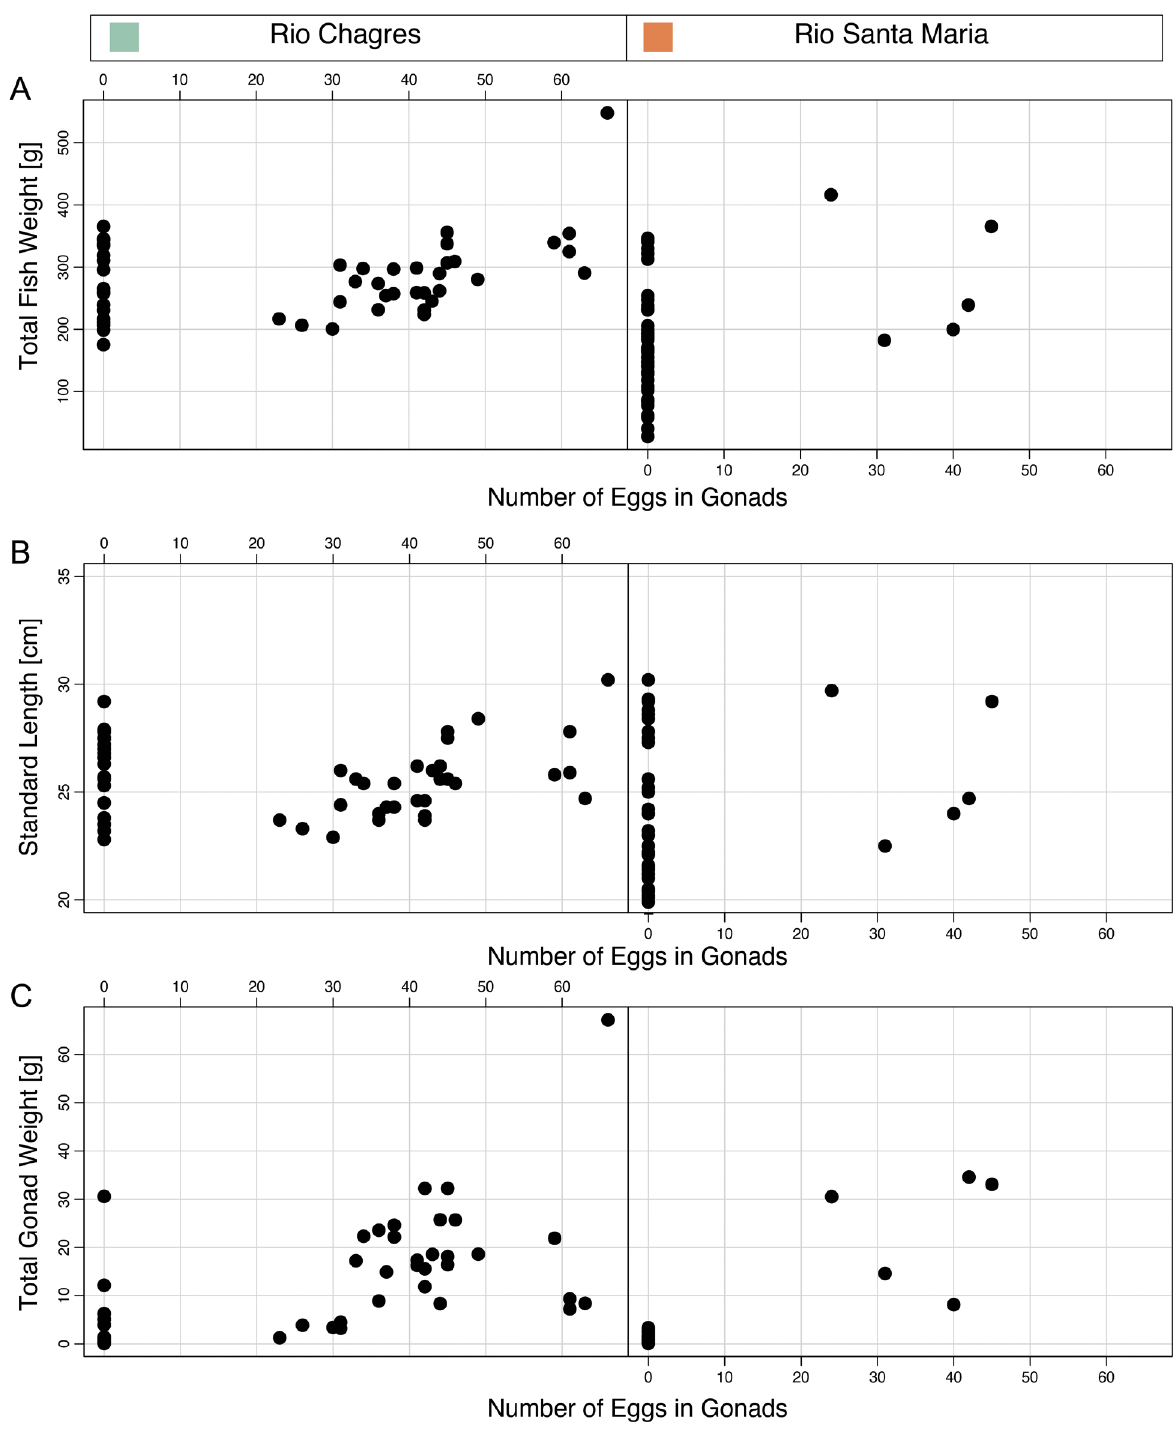
FIGURE 6 | Number of eggs of freshwater and brackish Cathorops tuyra females from Rio Chagres and Rio Santa Maria, Panama, respectively, plotted against total weight ( A ), standard length ( B ), and gonad weight ( C ). Specimens were caught February 2019 during mid dry season. From 50 specimens caught in Rio Chagres 37 specimens were identified as females of which 29 carried mature eggs. The Rio Santa Maria sample, contained individuals from all three size classes, 29 out of 51 specimens were identified as females, only 5 of which were in pre-spawning